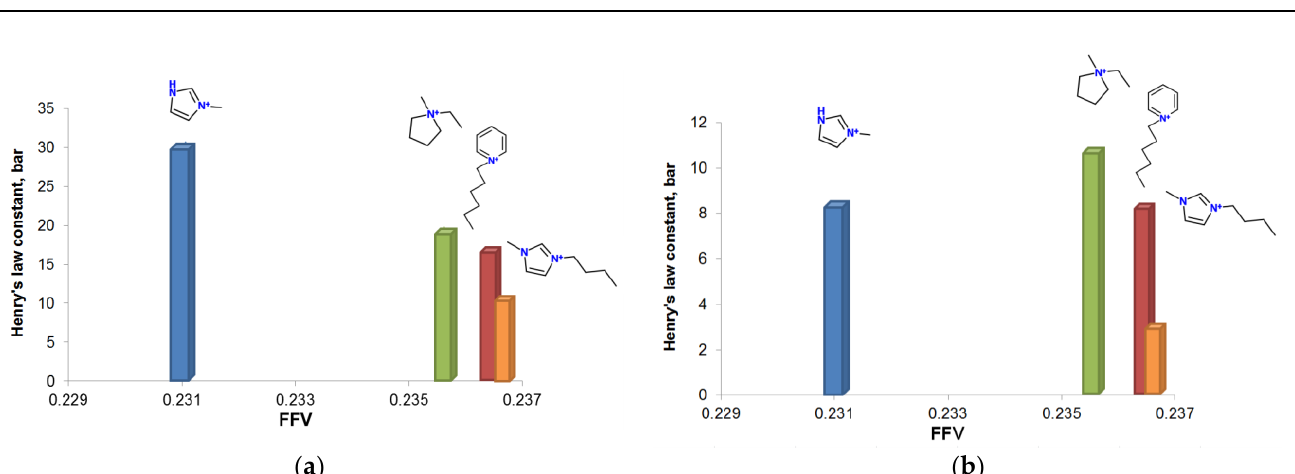
Figure 5. Henry’s law constants of CO 2 ( a ) and H 2 S ( b ) as a function of the fractional free volume for [doc]-based ionic liquids.